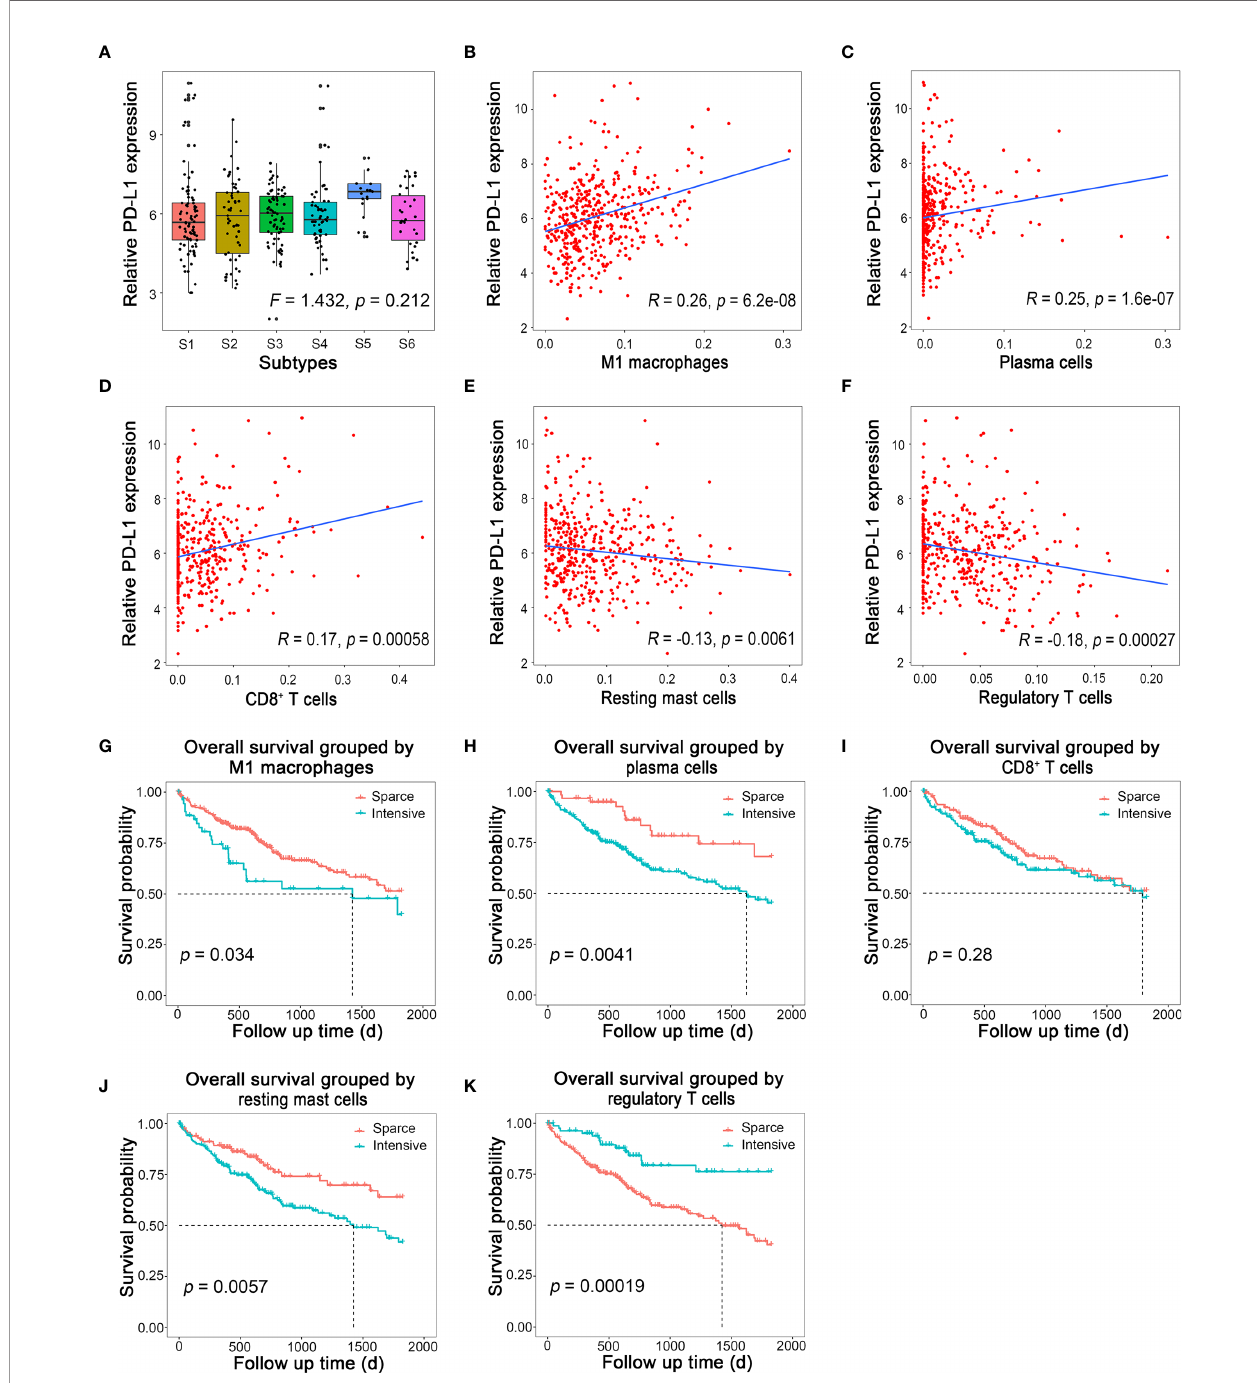
FIGURE 5 | Immune cells related to PD-L1 expression and their prognostic value. (A) Relative PD-L1 expression in different immune subtypes in HCC. (B – F) Linear regression of PD-L1 and M1 macrophages, plasma cells, CD8+ T cells, resting mast cells, and regulatory T cells, respectively. (G – K) Survival curves of M1 macrophages, plasma cells, CD8+ T cells, resting mast cells, and regulatory T cells,